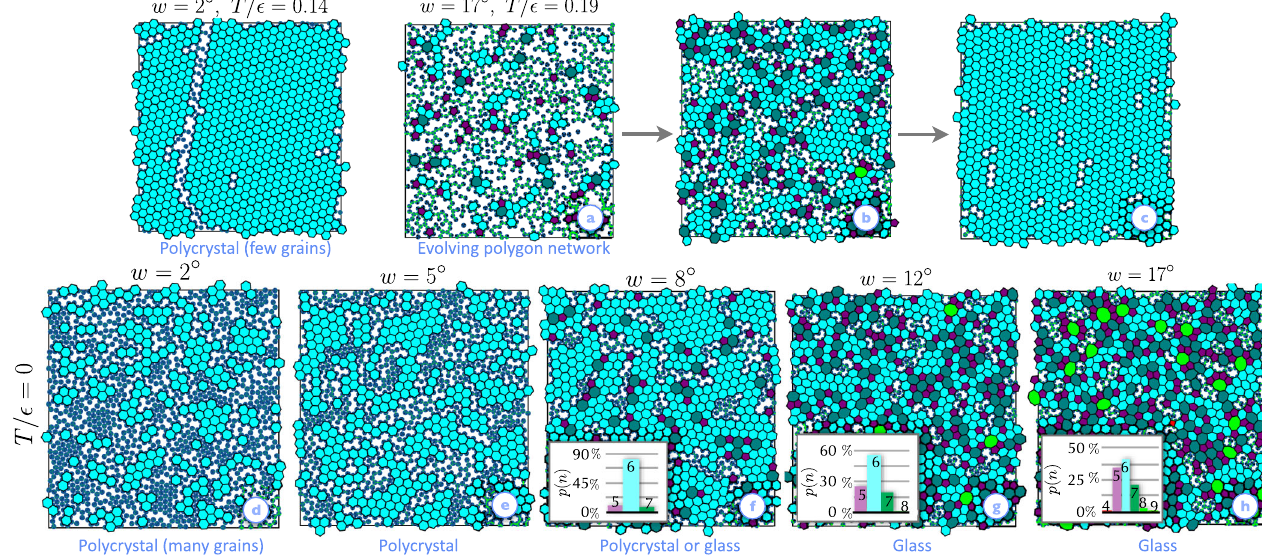
4. Snapshots of self-assembled model networks: Compare the behavior of real systems in Fig. 1. Disks with inflexible bonds (small w ) form polycrystals (left). Crystal grains are small if the binding strength is large (bottom), similar to cyclohexa- m -phenylene [9]. Disks with flexible bonds (right, large w ) form evolving polygon networks if their bonds are weak (top), similar to the hydrogen- bonding molecules of Ref. [10], and form glasses if their bonds are strong (bottom), similar to TBPB. (A side-by-side comparison of theory and simulation is shown in Fig. S9.) Lower-case letters a – h match phase points in Fig.